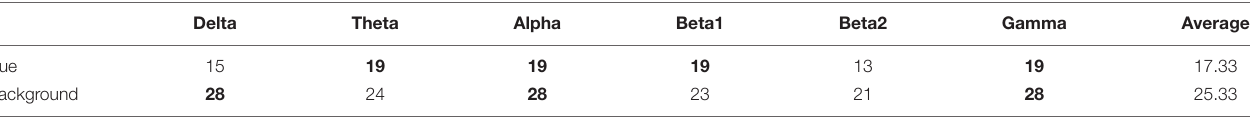
FIGURE 3 | The distributions of the importance scores of features in every frequency band are based on MRMR. (A,B) Are the two-dimensional coordinate maps, which show the importance score of EFs in descending order. (C,D) Are the topographic maps ( C: cue, D: background), black dots mark the channel positions of EFs in the corresponding frequency band. TABLE 3 | Number of EFs for each frequency